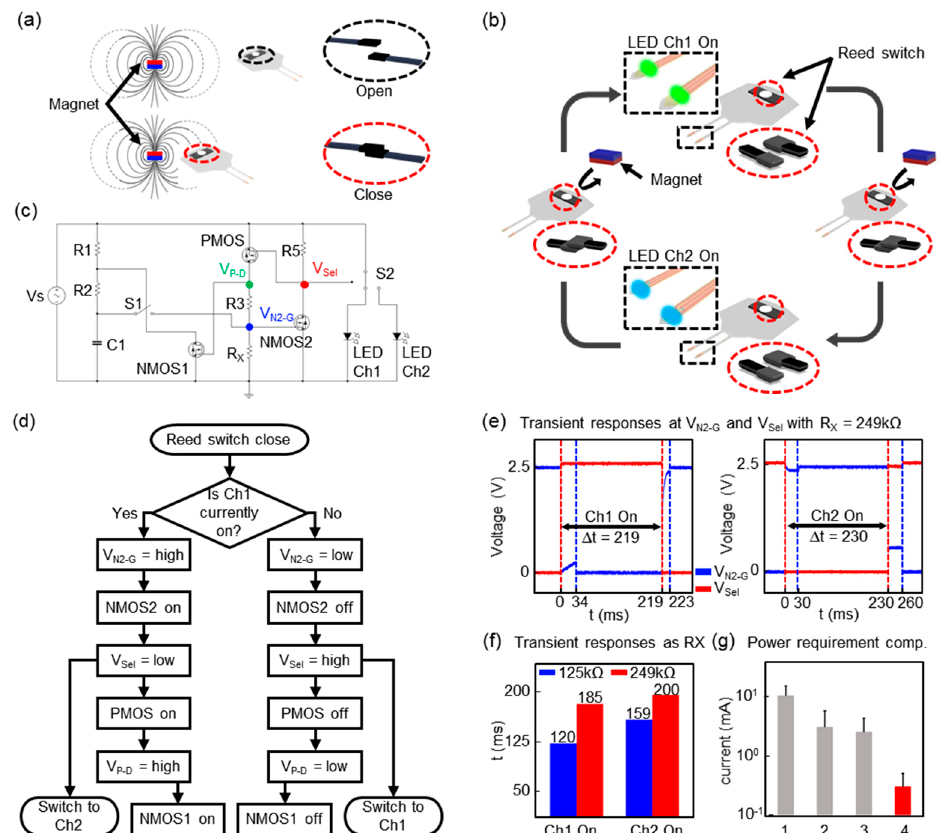
Figure 2. Electrical Characteristics of a dual channel wireless optogenetic device. ( a ) Essential feature of a reed switch. ( b ) Illustration of procedures for a channel selection of the proposed device by a magnet. ( c ) Circuit diagram of the control logic including a reed switch and LEDs. The reed switch and an analog switch IC are denoted by S1 and S2, respectively. V P-D , V N2-G, and V Sel represent a level of voltages at the PMOS drain, NMOS2 gate, and a selection input port of an analog switch, respectively. The rest of the parameters for capacitors and resistors are C1 = 1 µ F, R1 = R2 = 249 k Ω , R3 = 10 k Ω , R5 = 20 k Ω . ( d ) A flowchart for an actuation mechanism enabled by a reed switch. ( e ) Plots of the transient responses at V N2-G , and V Sel , respectively, during the transition from Ch 1 to Ch 2 (Left) or vice versa (Right). Here, the dotted lines indicate the moment at which S1 closes (Red) or opens (Blue). ( f ) Plot of the measurements of the threshold time for switching as a function of R x . ( g ) Comparisons of the power consumption of the proposed system (denoted, 4) with that of µ C (denoted, 3), NFC (denoted, 2), and Bluetooth (denoted, 1) devices,